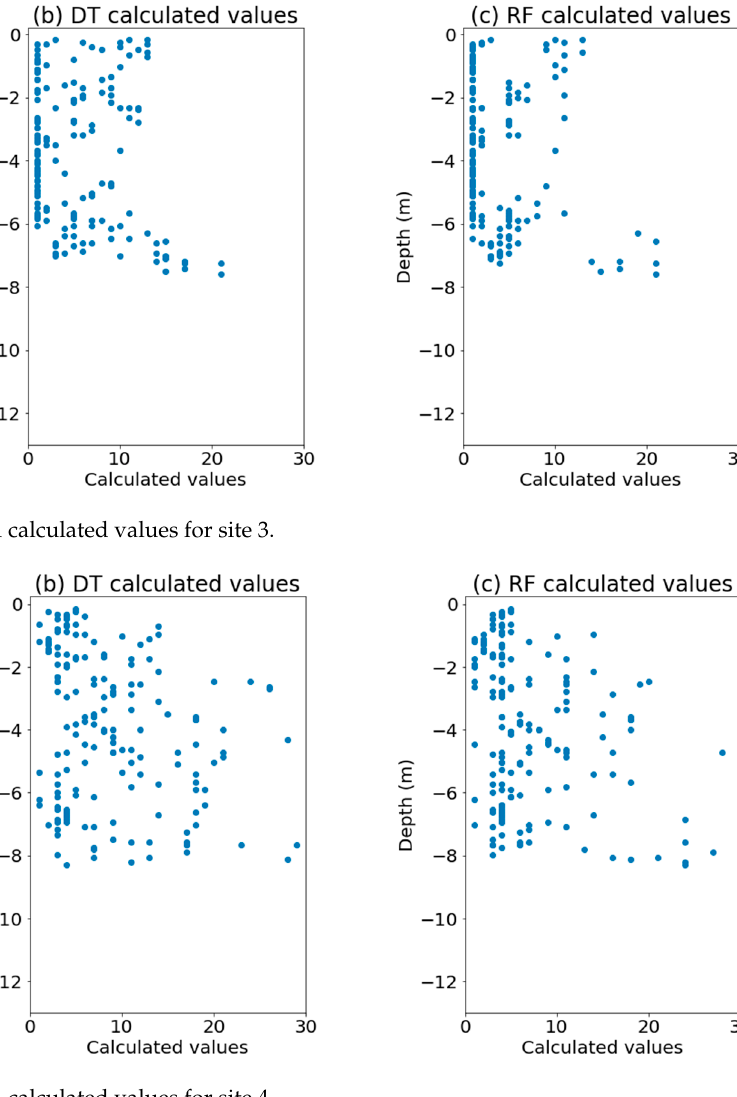
Figure 14. Real and calculated values for site 4. ( a ) Real values. ( b ) Values calculated by DT. ( c ) Values calculated using RF.